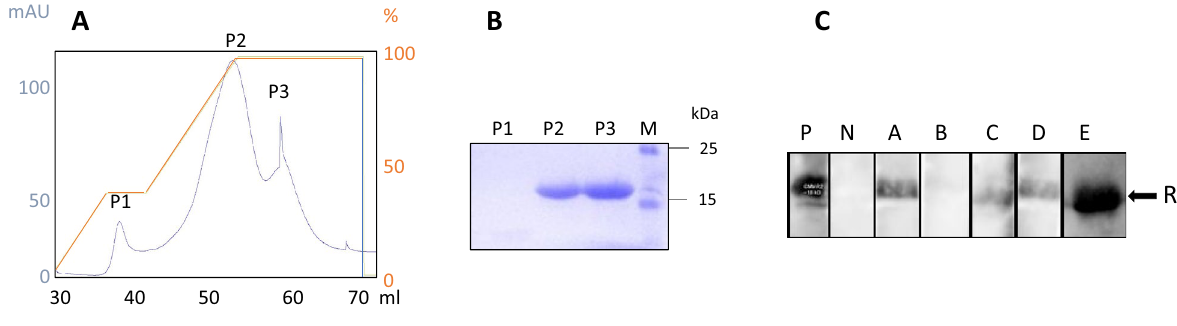
Figure 2. ( A ) HisTrap column elution profile of the recombinant R2 fragment of gB of PCMV/PRV, ( B ) SDS-PAGE of the purified R2 fragment. P2 and P3 correspond to the peak fractions shown in ( A ), ( C ) Result of the Western blot analysis of sera from adult pigs A, B, C, D and E. A to E pigs were around 4 months old. P, positive control, N, negative control. Serum dilution 1:300, goat anti-pig horse reddish peroxidase was used for detection. Blots were cut prior to hybridization with antibodies during blotting, each stripe was incubated with an individual serum.